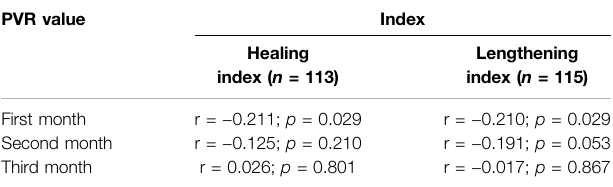
TABLE 7 | Associations of the healing index and lengthening index with the early PVR value.